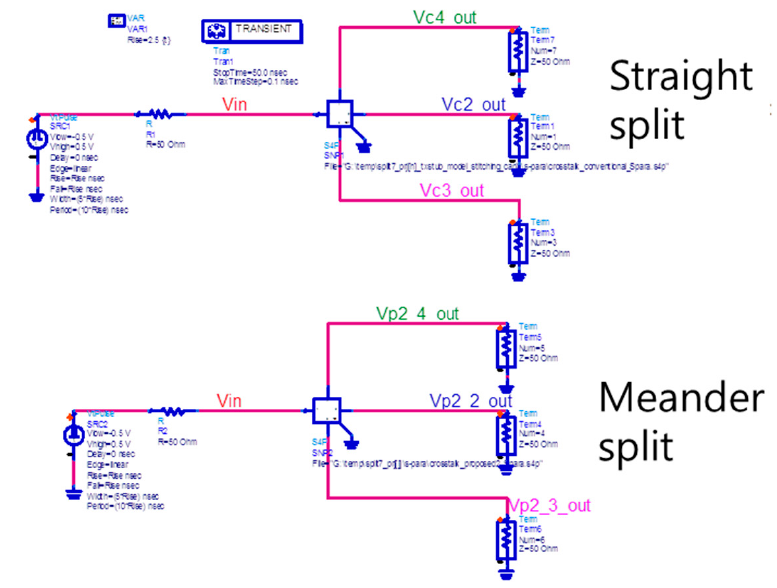
Figure 10. Time simulation of the crosstalk signal of the straight and meander split ground plane.